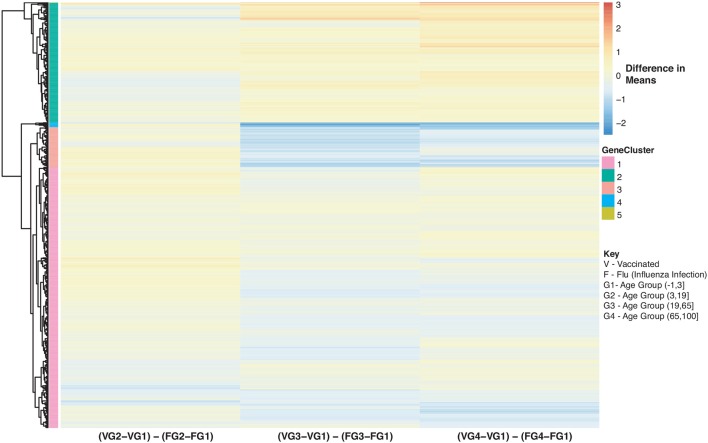
Heatmap of Statistically Significant (Bonferroni-adjusted p < 0.05) Genes with an Interaction Between Disease State and Age for Influenza Vaccinated Subjects Compared to Influenza Infected Subjects. Comparison of baseline-adjusted means for influenza vaccinated subjects (Figure 10A) and influenza infected subjects (Figure 9A).